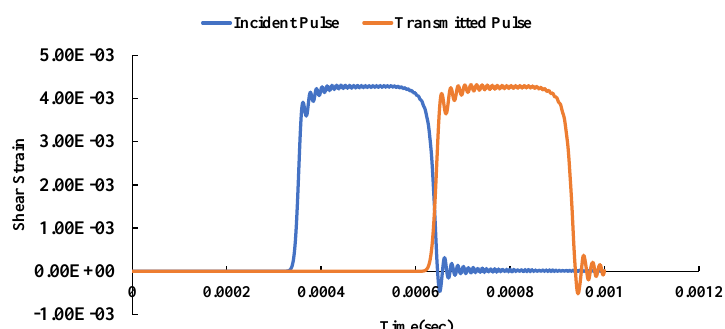
Fig.7. Calibration to find the effectiveness of Tie constraint